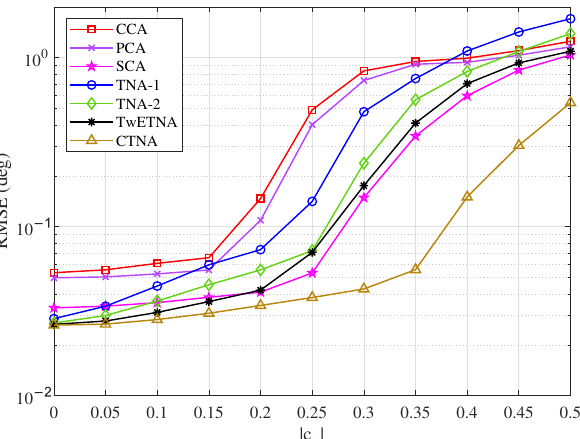
Figure 9. RMSE versus mutual coupling coefficient | c 1 | , where SNR = 0 dB, T = P =